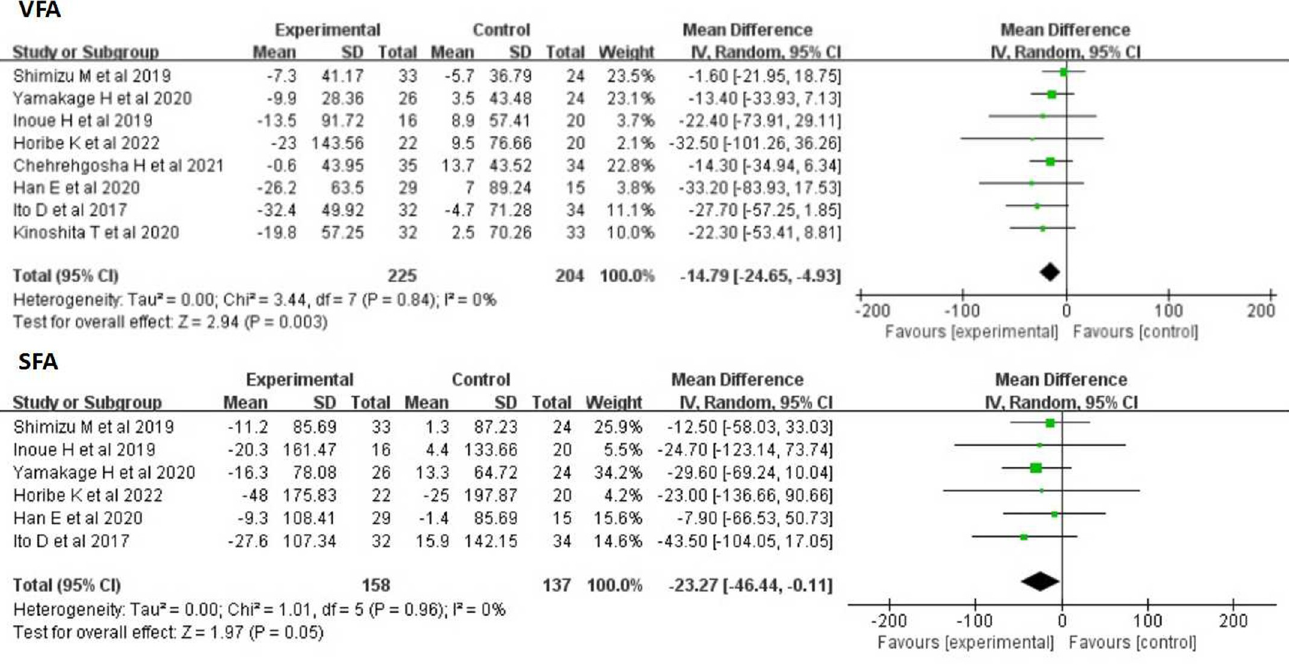
Fig 3. Forest plots depicting VFA and SFA comparisons between SGLT-2 inhibitors and the control group.